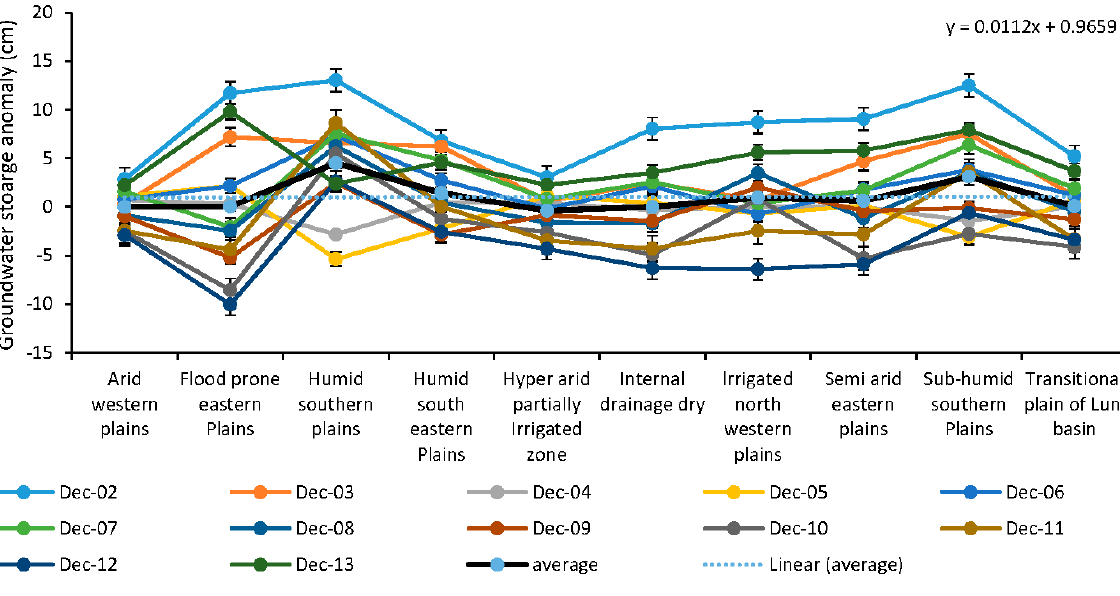
Figure 11. Variations in agroclimatic zonal GRACE estimates of groundwater storage anomaly in the Indian state of Rajasthan for the month of December. Bars indicate standard